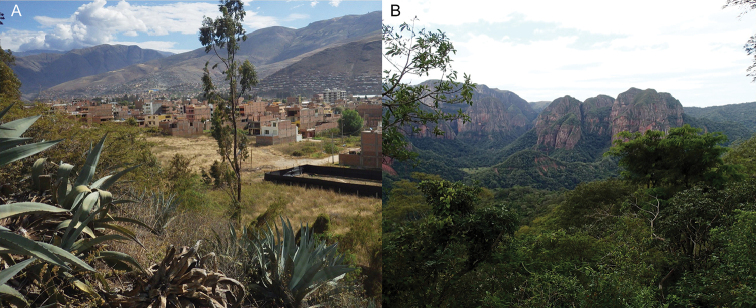
Biomes for new RugitermesAR.
aridusBR.
rufus and R.
volcanensis.